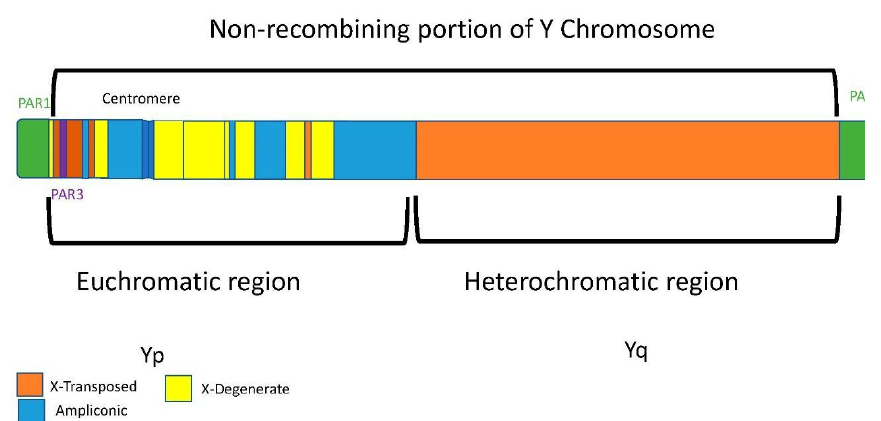
Figure 3. Y Chromosome structure.